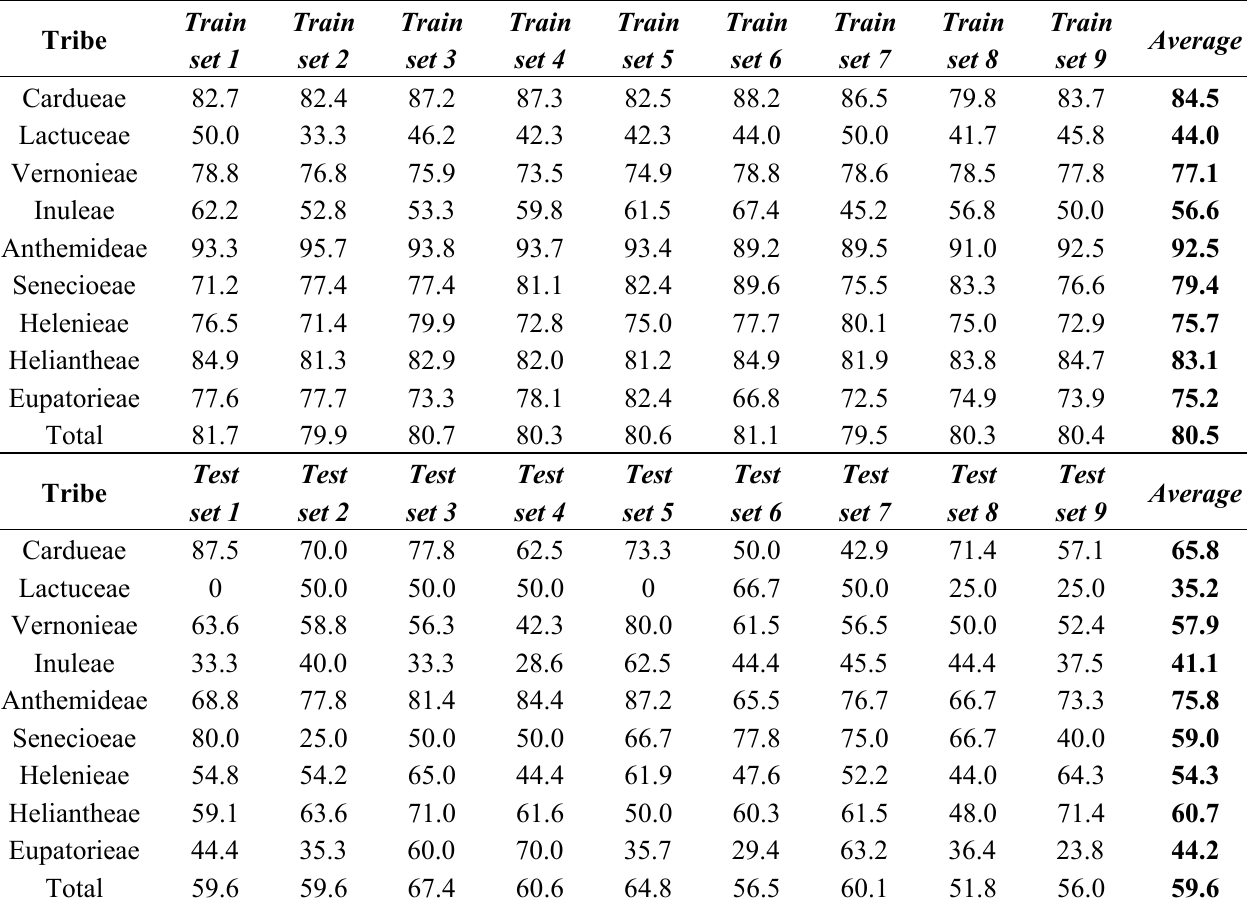
Table 5. Summary of training and test match results (%) using RDF